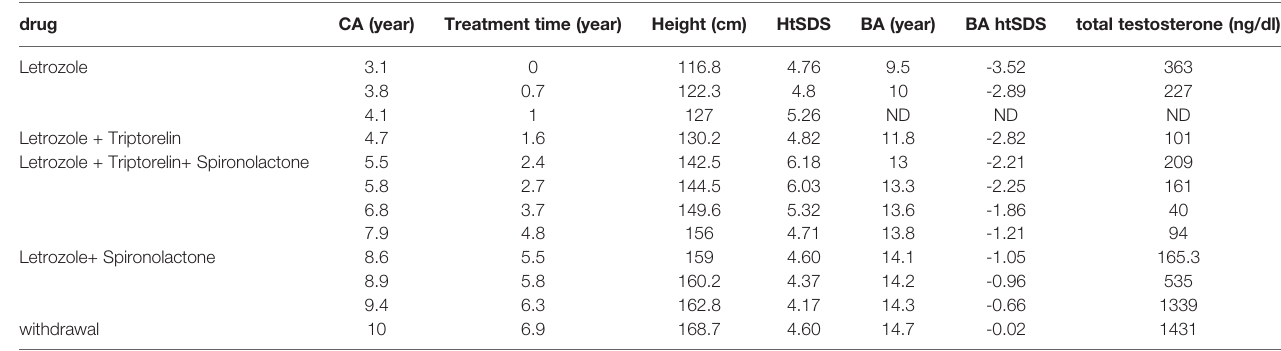
TABLE 2 | follow-up of the patient with